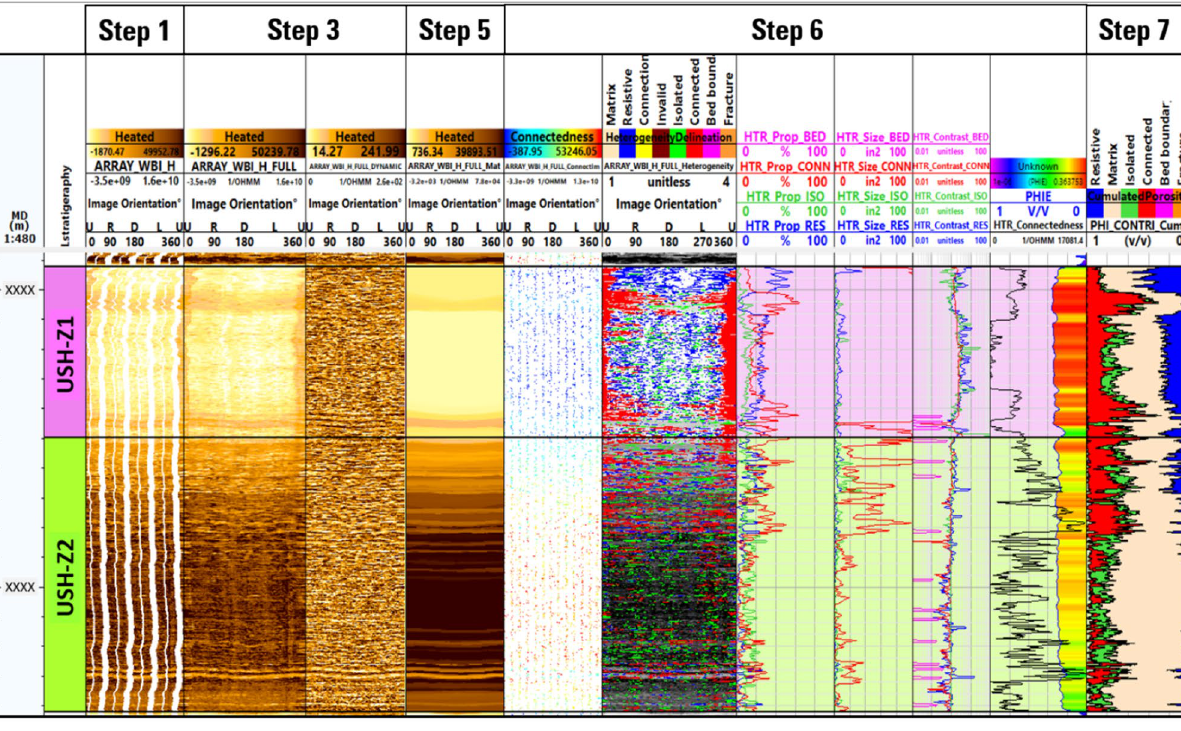
edness image log, Track 8: Heterogeneity image, Track 9: Porosity spectrum value, Track 13: Image porosity